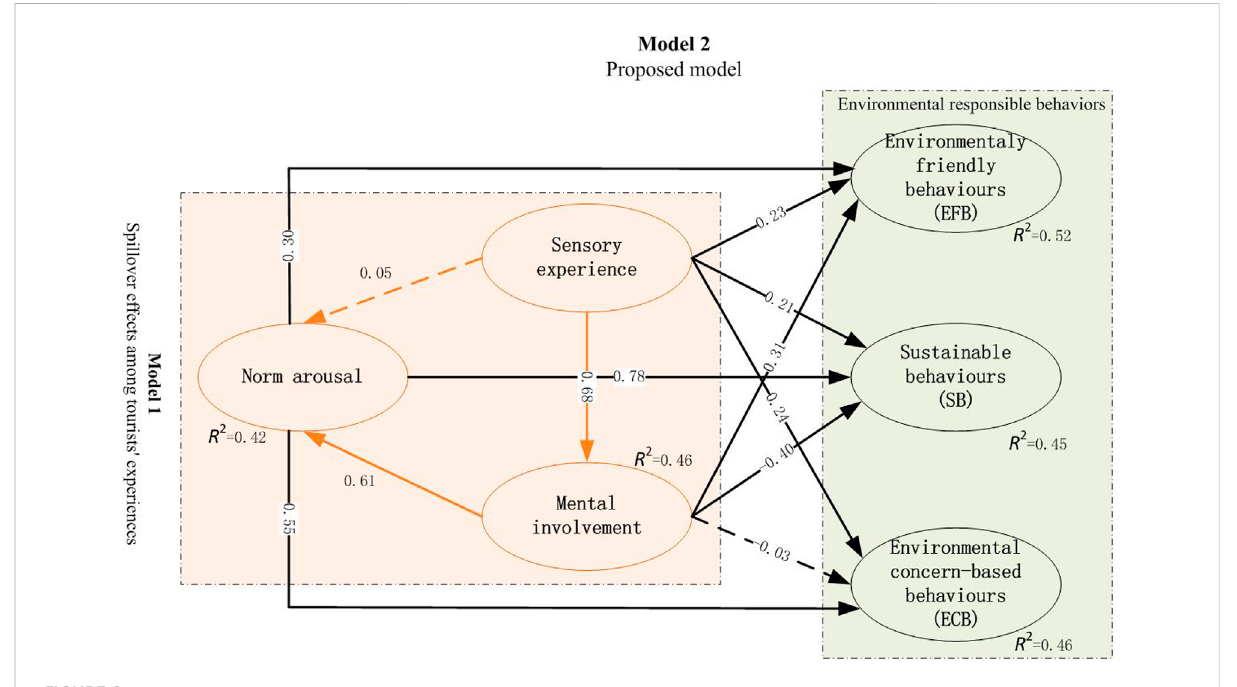
FIGURE 2 Results of the structural